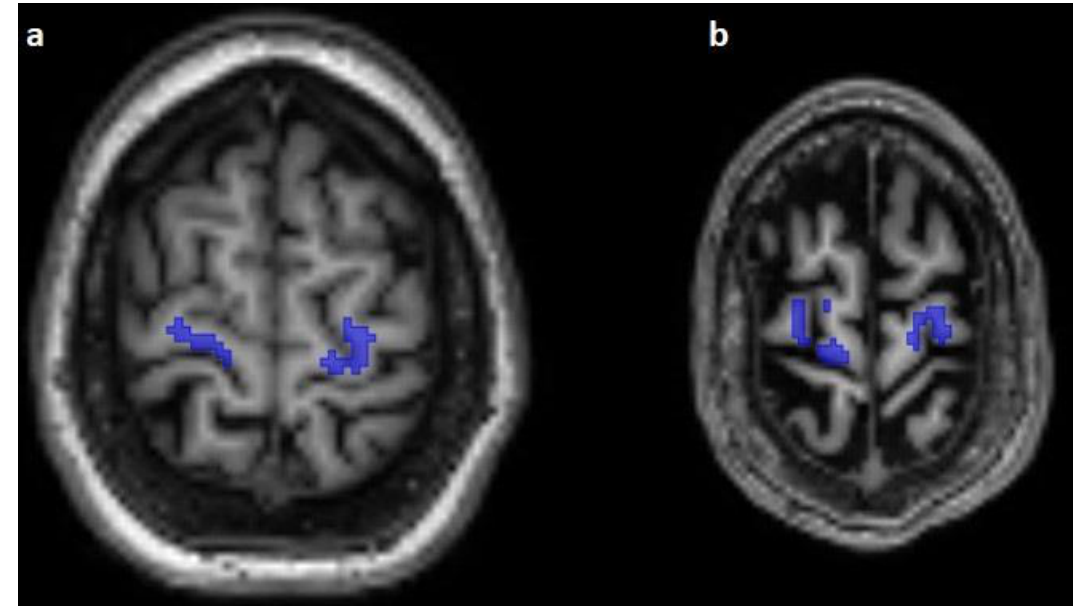
Figure 3. The predicted course of the corticospinal pathway (blue) in the subcortical white matter of the precentral gyrus on axial T1-weighted images. Note the absence of predicted fibers in the subarachnoidal space as well as the fibers following the pattern of the minor gyri ( a , b ). The predicted pathway originated from the centrum semiovale directly under the precentral gyrus in 11/100 (11%) cases; 4 subjects (4/25, 16%) were affected in the Emotion regulation dataset, with 3 on the right side and 1 on the left side, and 7 subjects (7/15, 46.67%) were affected in the interTVA dataset, with 4 on the right side, 1 on the left side, and 2 on both